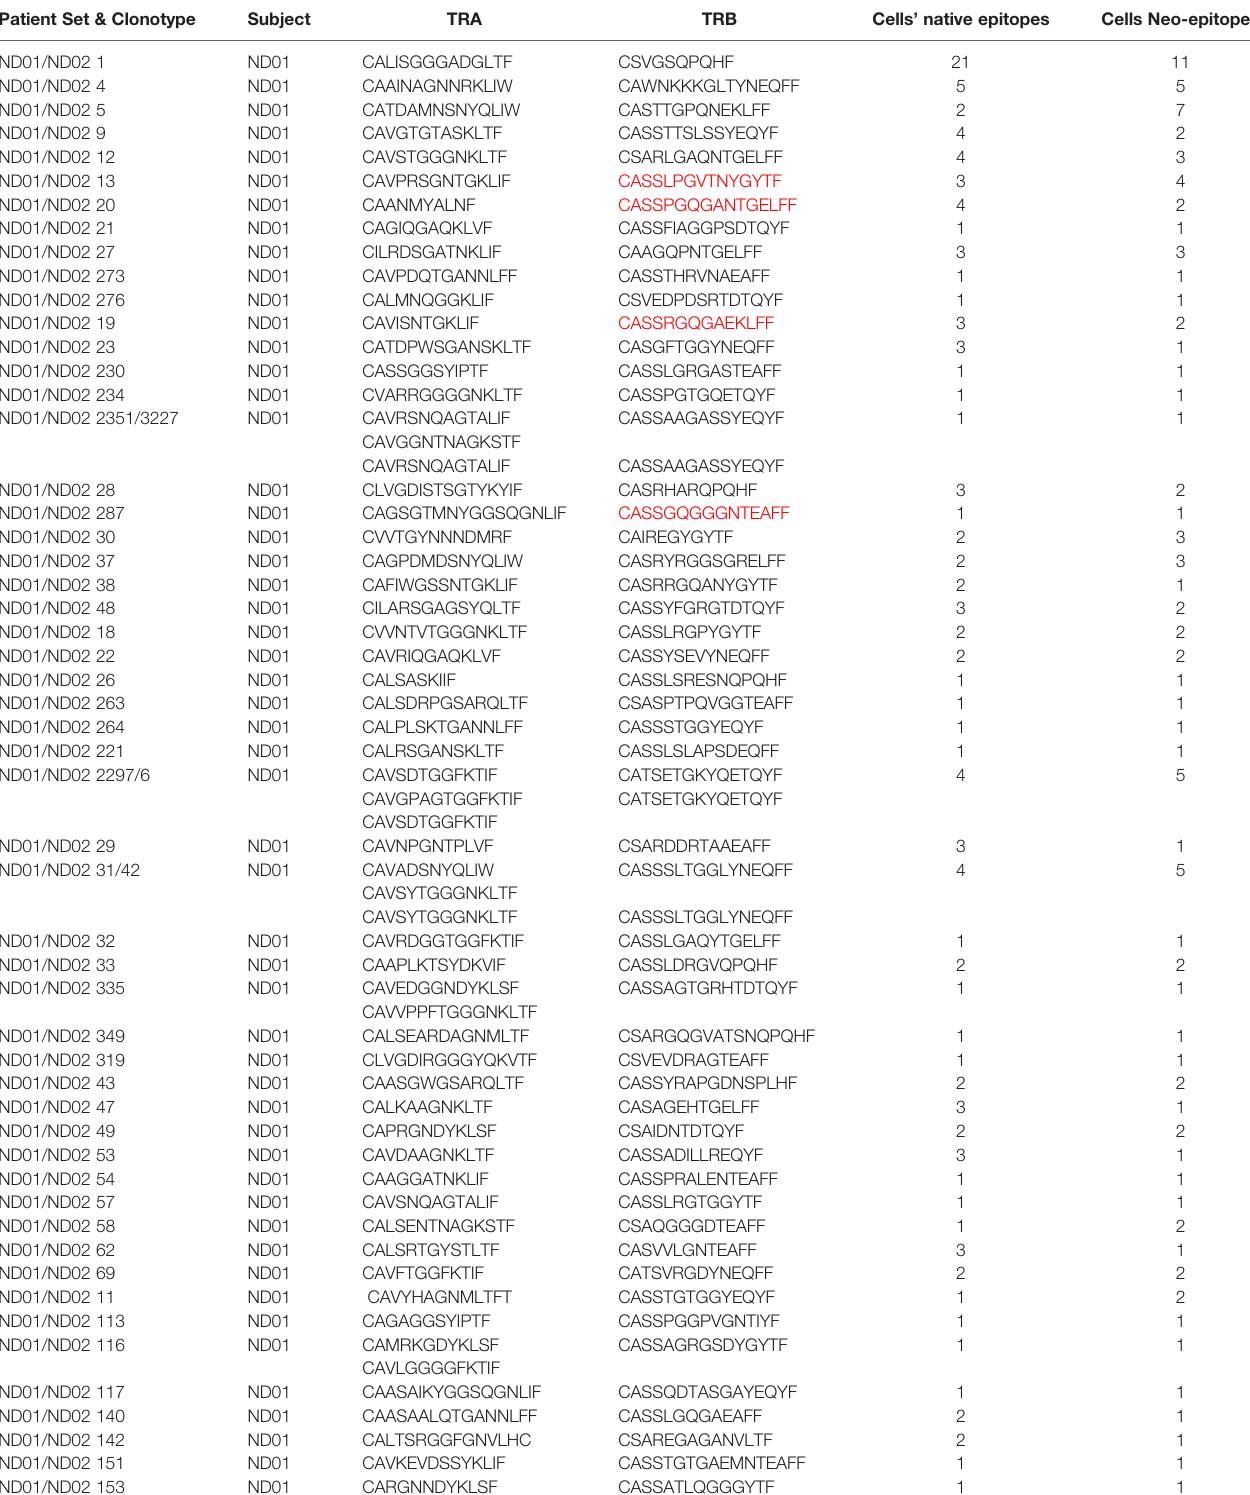
TABLE 2 | T cell clonotypes shared amongst native and neoepitopes. Patient Set &